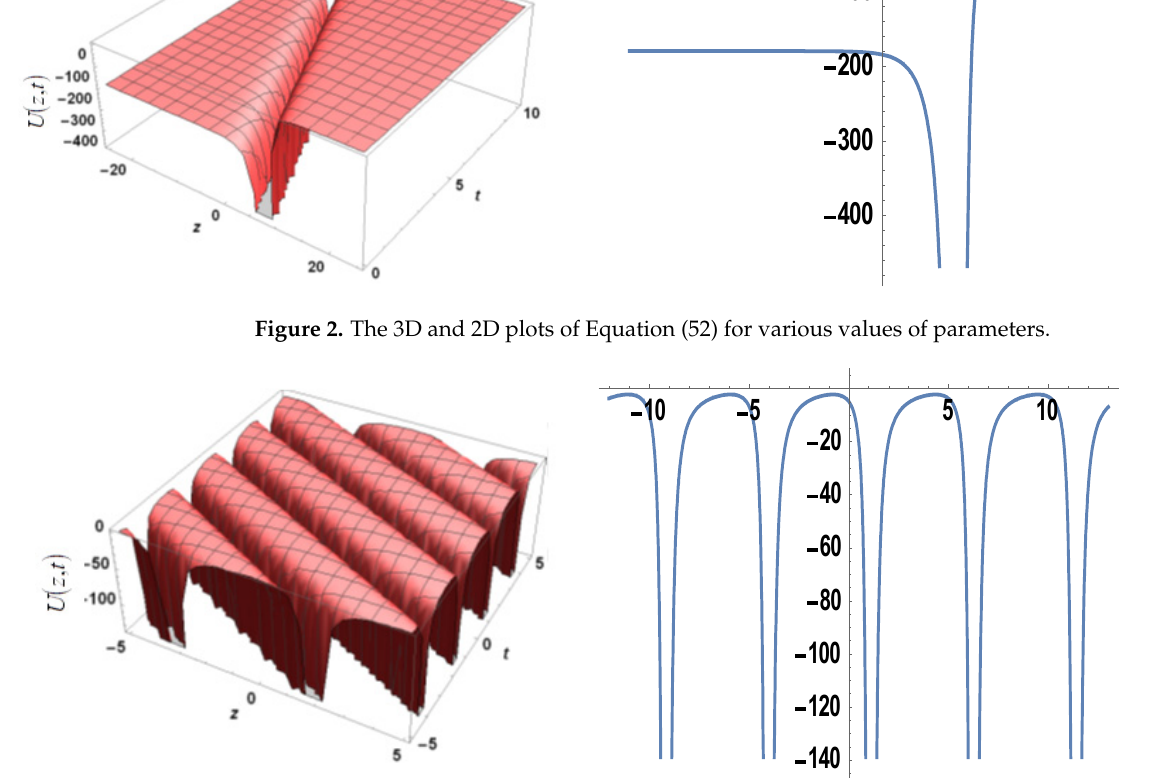
Figure 3. The 3D and 2D plots of Equation (53) for various values of parameters.